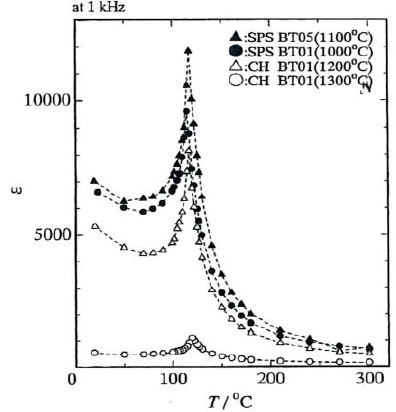
Figure 29. Temperature dependence of permittivity at 1 kHz for SPS and conventional hot pressing (CH) on BaTiO 3 pellets.